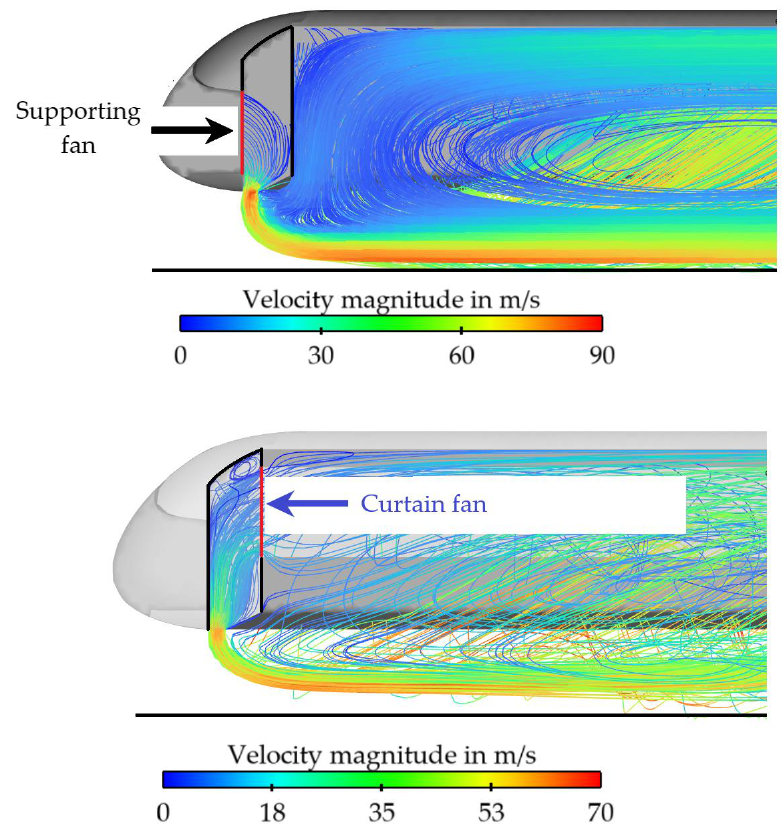
Figure 17. Scheme of operation of the supporting fan and circulation fan.